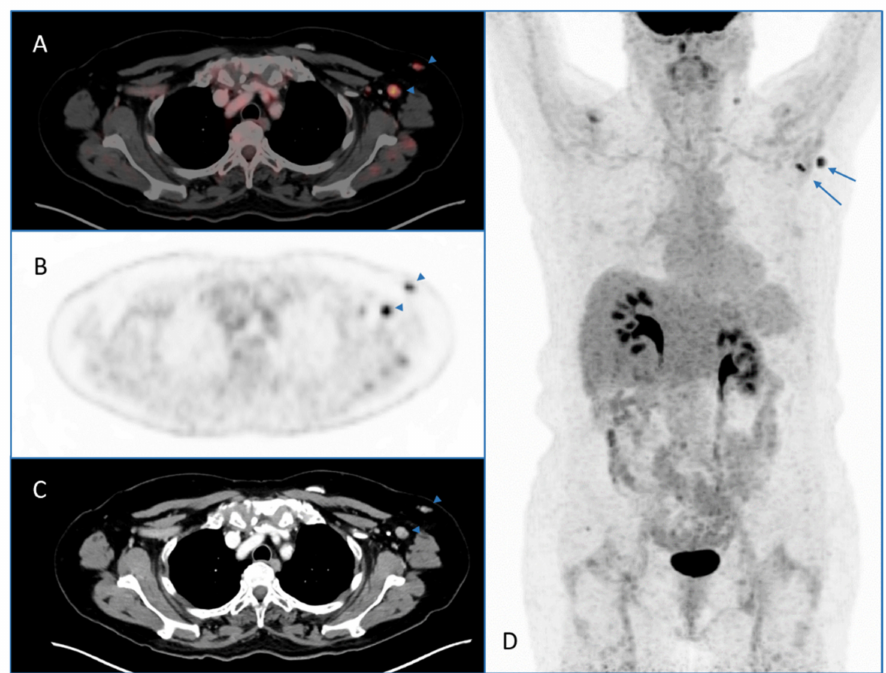
Figure 1. 2-[ 18 F]FDG PET/CT performed for oncological indication in a patient with previous COVID-19 vaccination (3 weeks before 2-[ 18 F]FDG PET/CT). Axial PET/CT ( A ), PET ( B ), and CT ( C ) images and maximum intensity projection (MIP) PET image ( D ) showed hypermetabolic axillary lymph nodes due to increased 2-[ 18 F]FDG uptake in the left axillary region (arrows). These findings were judged as reactive lymph nodes after COVID-19